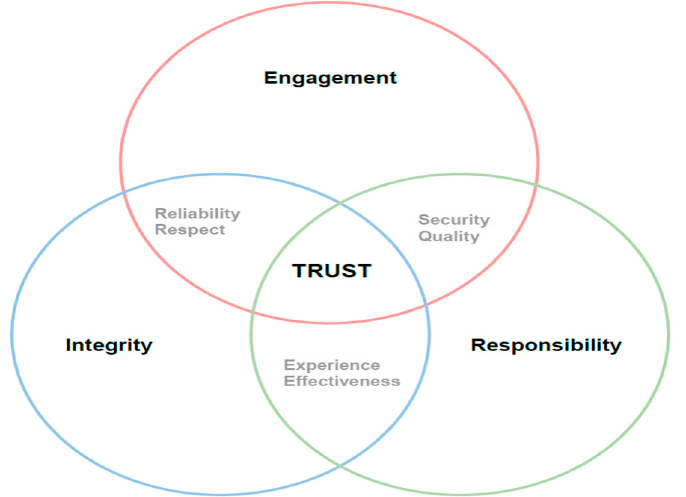
Figure 3. Trustworthy relationships between the Contractor and subcontractors. Source: Authors.